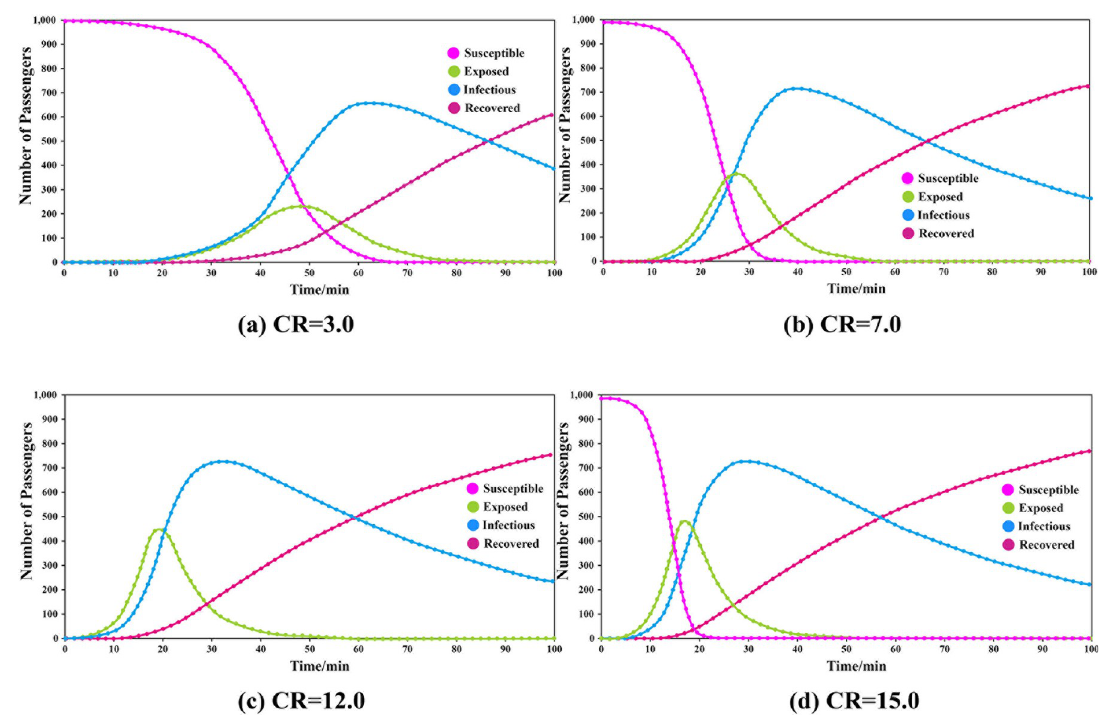
Fig 2. Results of different groups under different contact